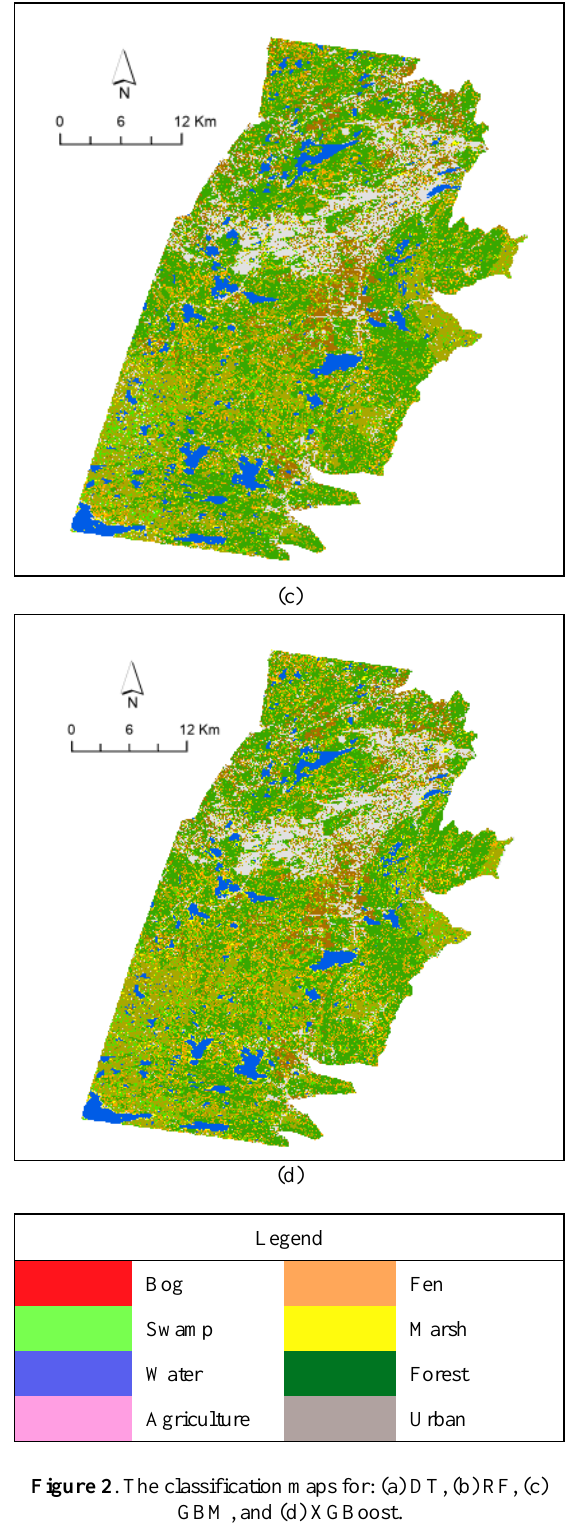
Figure 2 . The classification maps for: (a) DT, (b) RF, (c) GBM, and (d)